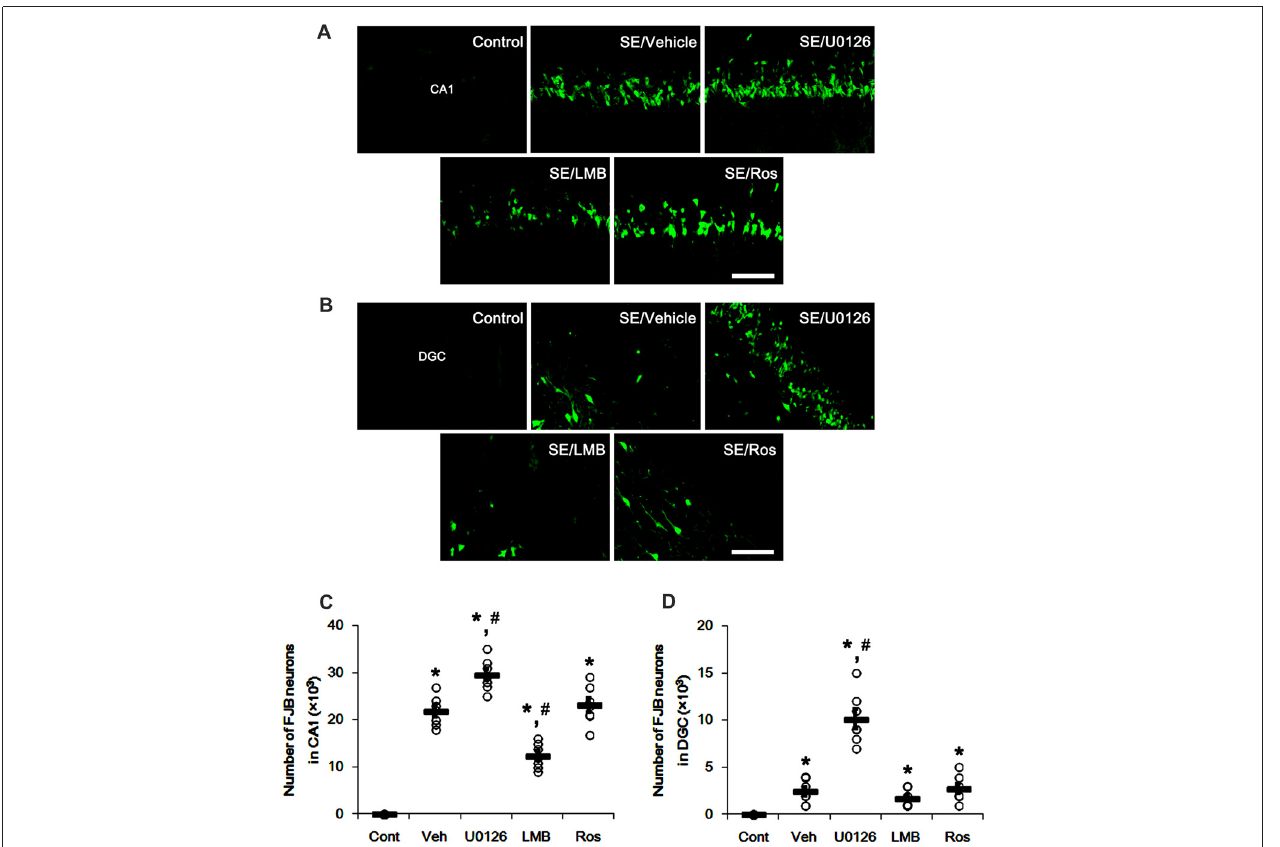
FIGURE 8 | Effects of U0126, LMB and roscovitine on neuronal damage in the CA1 region and the dentate gyrus. (A,B) Representative images for Fluoro-Jade B (FJB) signals in CA1 neurons (A) and DGC (B) Bar = 50 µ m. As compared to vehicle, U0126 deteriorates SE-induced neuronal damage in CA1 neurons and DGC, while LMB attenuates neuronal damage only in CA1 neurons. Roscovitine does not affect SE-induced neuronal death in CA1 neurons and DGC. (C,D) Quantification of the number of FJB-positive CA1 neurons (C) and DGC (D) Open circles indicate each individual value. Horizontal bars indicate mean value. Error bars indicate SEM ( ∗ ,# p < 0.05 vs. control and vehicle, respectively; n = 7,